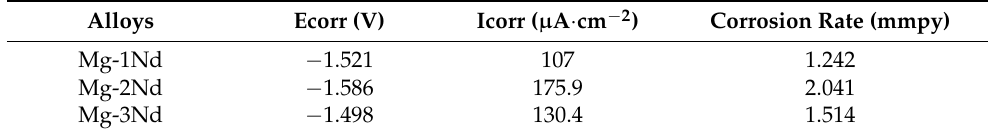
Table 2. Polarization curve fitting parameters for F-state Mg-Nd alloys.